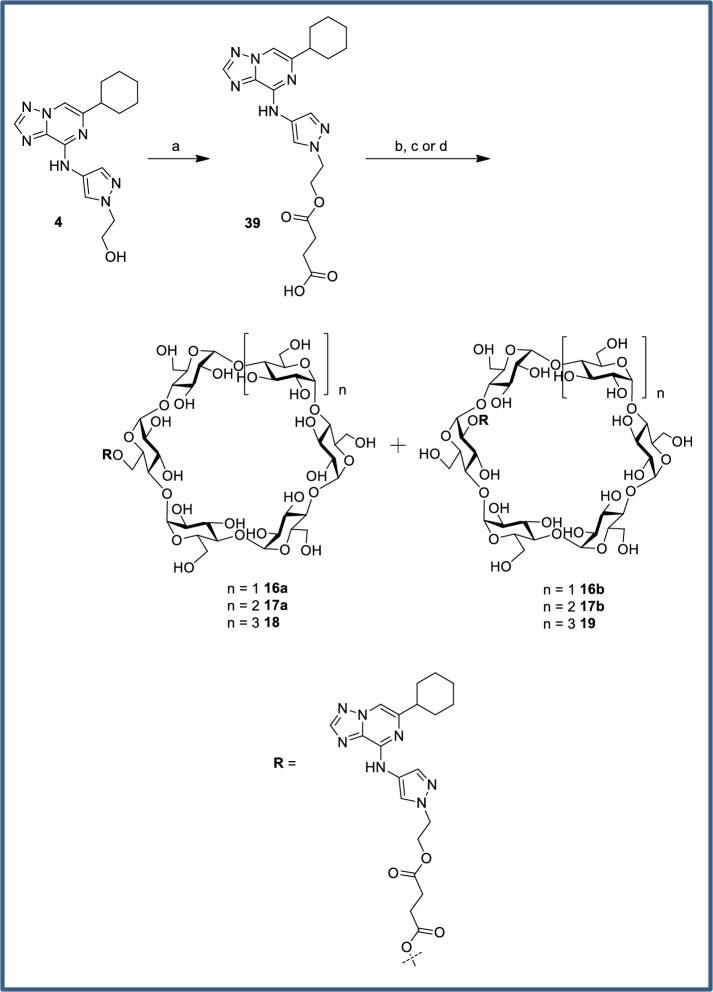
Chemical Synthesis of primary alcohol-linked cyclodextrin prodrugs.Reagents and conditions: (a) Et3N, succinic anhydride, DMAP, DCM, rt, 71%; (b) α-cyclodextrin, EDCI, DMAP, rt, 22%, 68:32 mix of 16a:16b; (c) β-cyclodextrin, EDCI, DMAP, rt, 5.2% 17a only; (d) γ-cyclodextrin, EDCI, DMAP, rt, 14% 18, 17% 19.